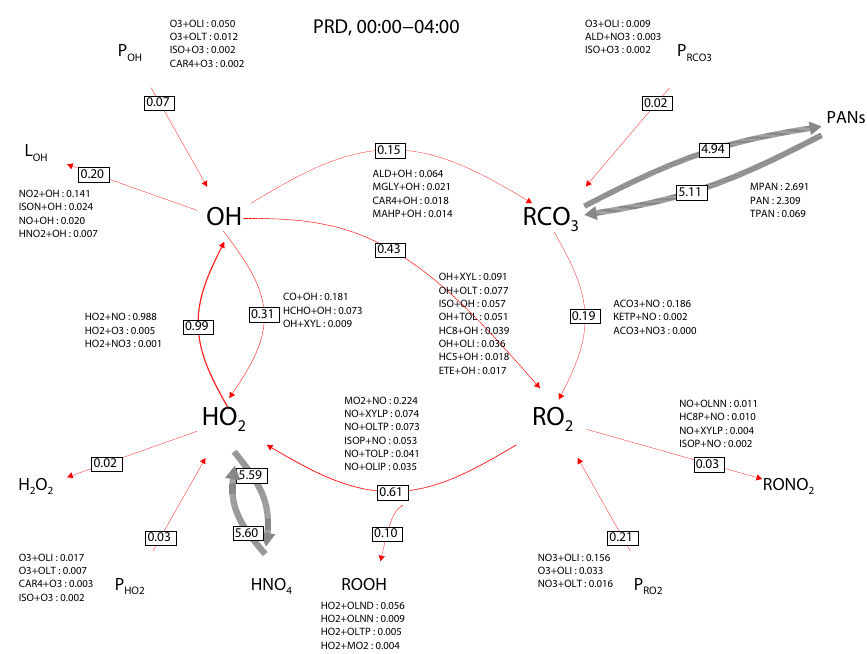
Figure 7. Mean RO x production, conversion, and destruction rates calculated by the base model (M0) for PRIDE-PRD2006 conditions during 00:00–04:00CNST. The thickness of the arrows represents the relative magnitude of the reaction rates given in ppbh − 1